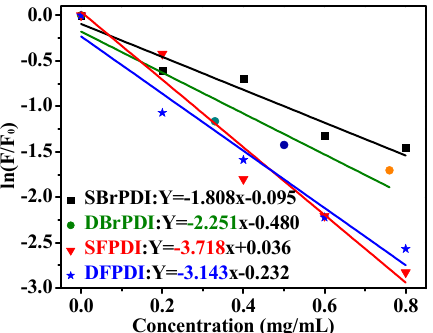
Figure 3. The relationship between quenching efficiency and GO concentration. F: fluorescence intensity of dyes; F 0 : fluorescence intensity after adding GO.